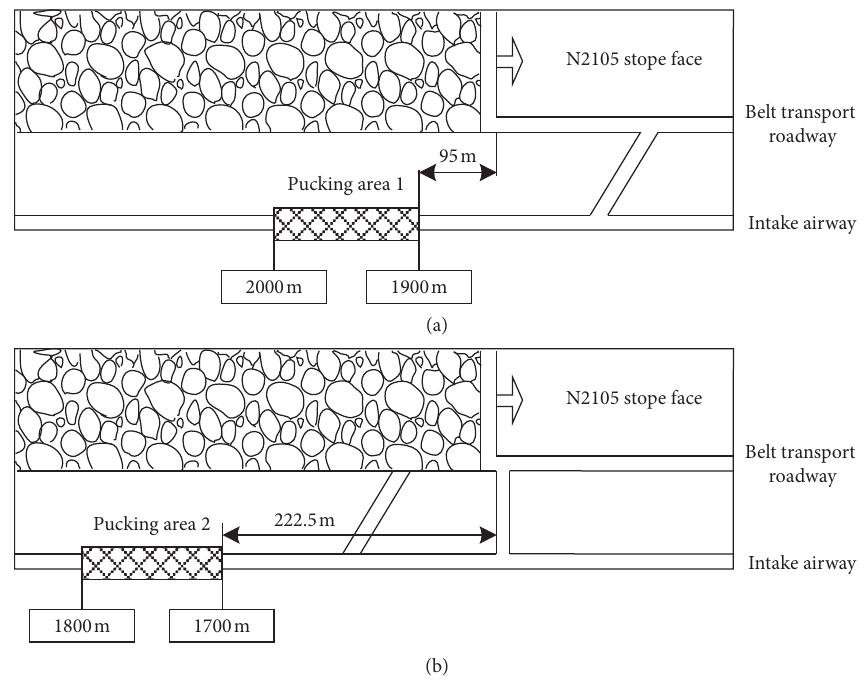
Figure 1: Diagram of two dynamic display positions.